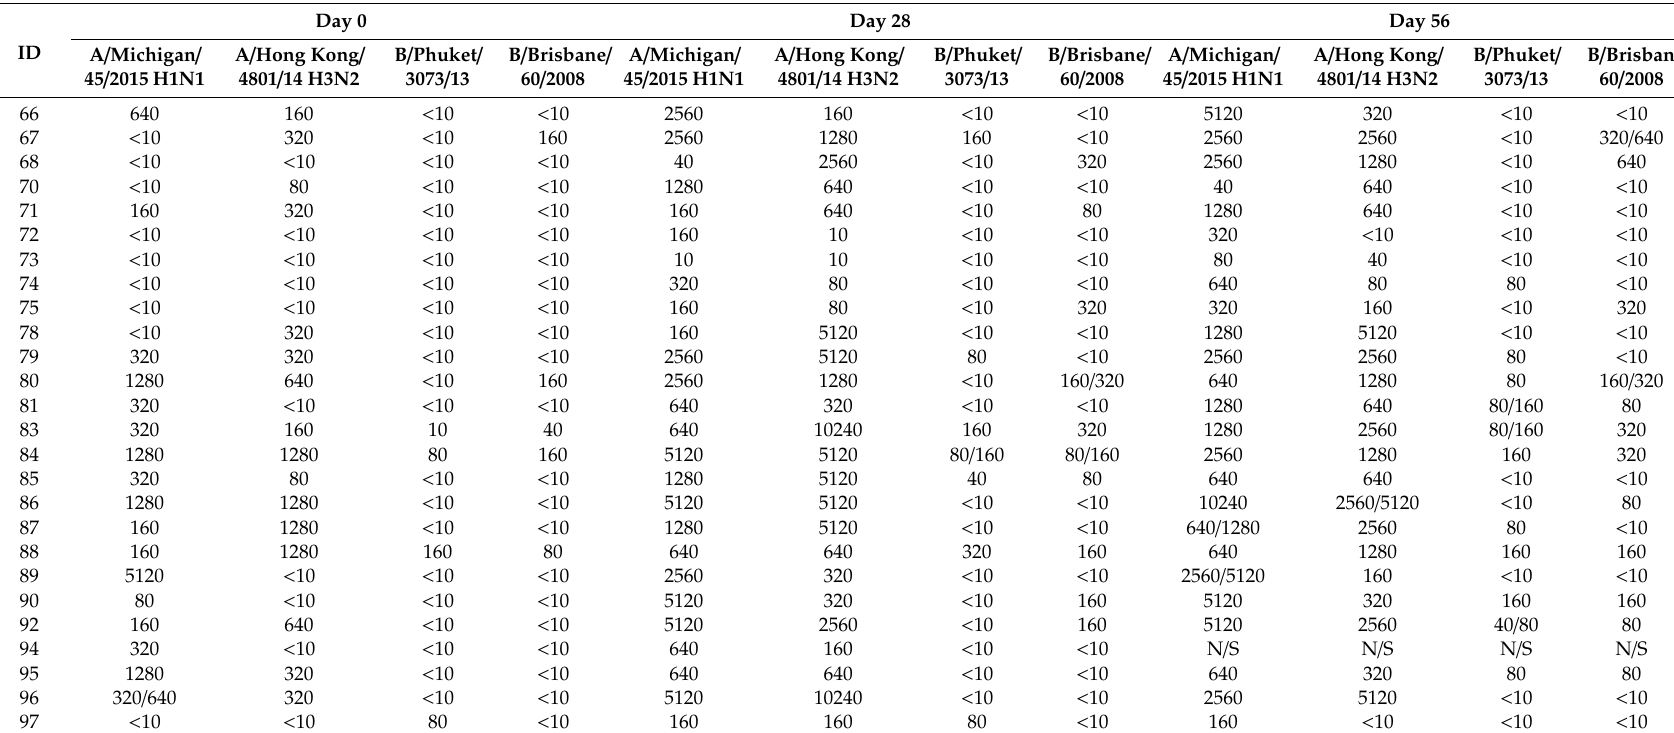
Table A6. HAI results